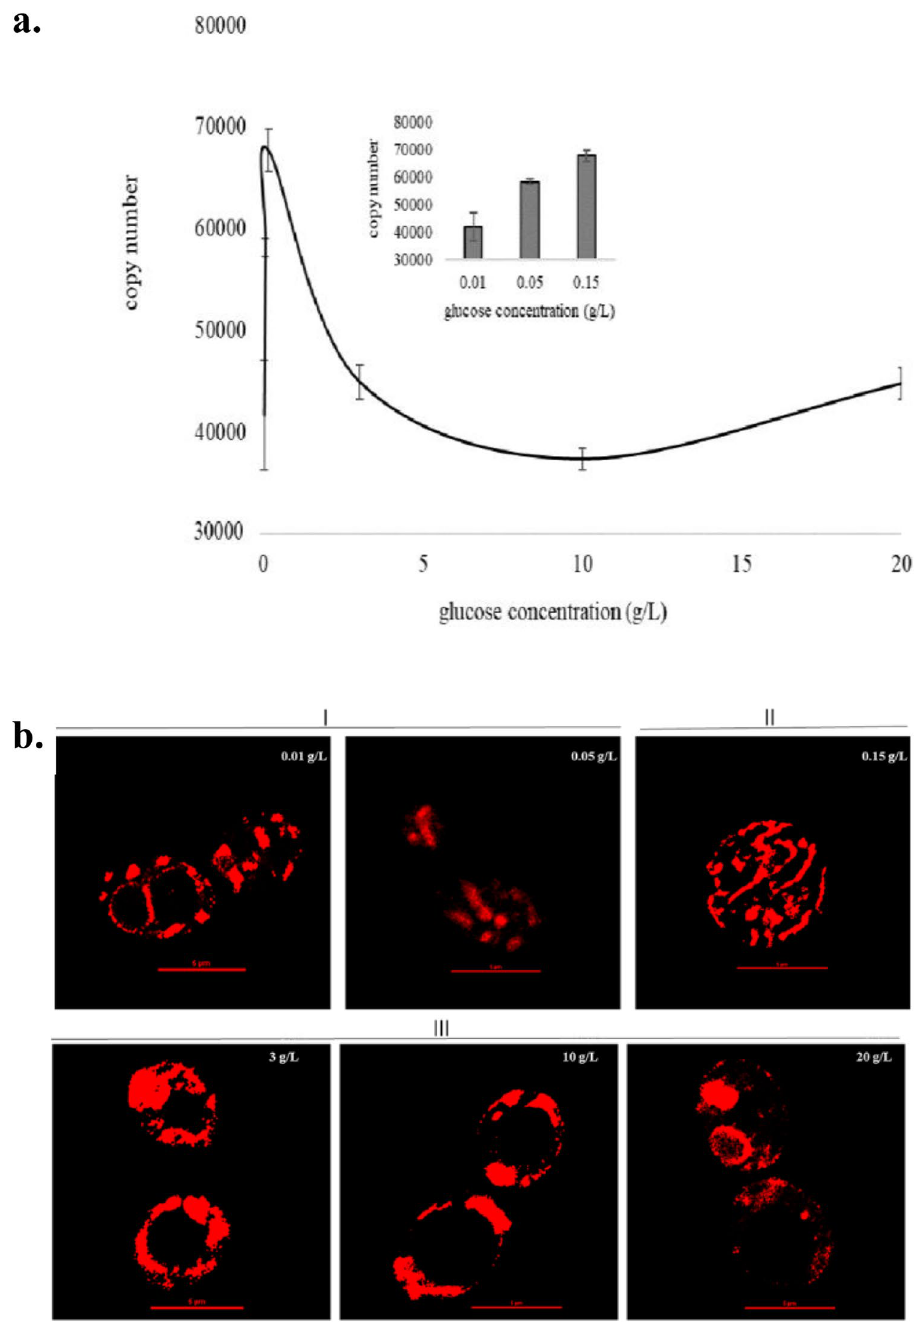
Figure 3. Mitochondrial DNA (mtDNA) copy number ( a ) and morphology imaging ( b ) of yeast cell cultured in 0.01, 0.05, 0.15, 3, 10 and 20 g/L glucose for 3 h. Insert data in Fig. 3a represented mtDNA copy number of yeast cells in 0.01, 0.05, and 0.15 g/L glucose for 3 h. Mitochondrial morphology in ( b ) were divided into three groups, group I included cells under 0.01 and 0.05 g/L glucose, group II included cells under 0.15 g/L glucose, group III included cells under 3, 10 and 20 g/L glucose. Scale bar, 5